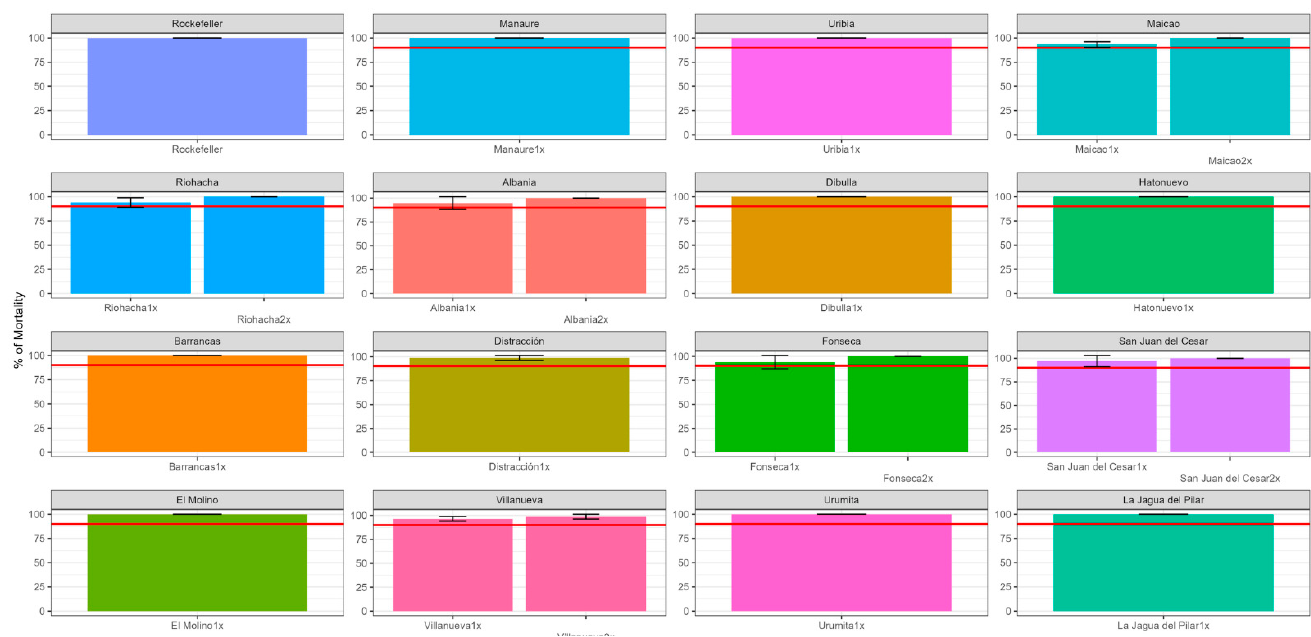
7 of 16 Figure 3. Mortality (with standard deviation) of Ae. aegypti following exposure to 1× DD of deltame- thrin in bottle bioassays. The red lines indicate the resistance threshold (90% mortality).